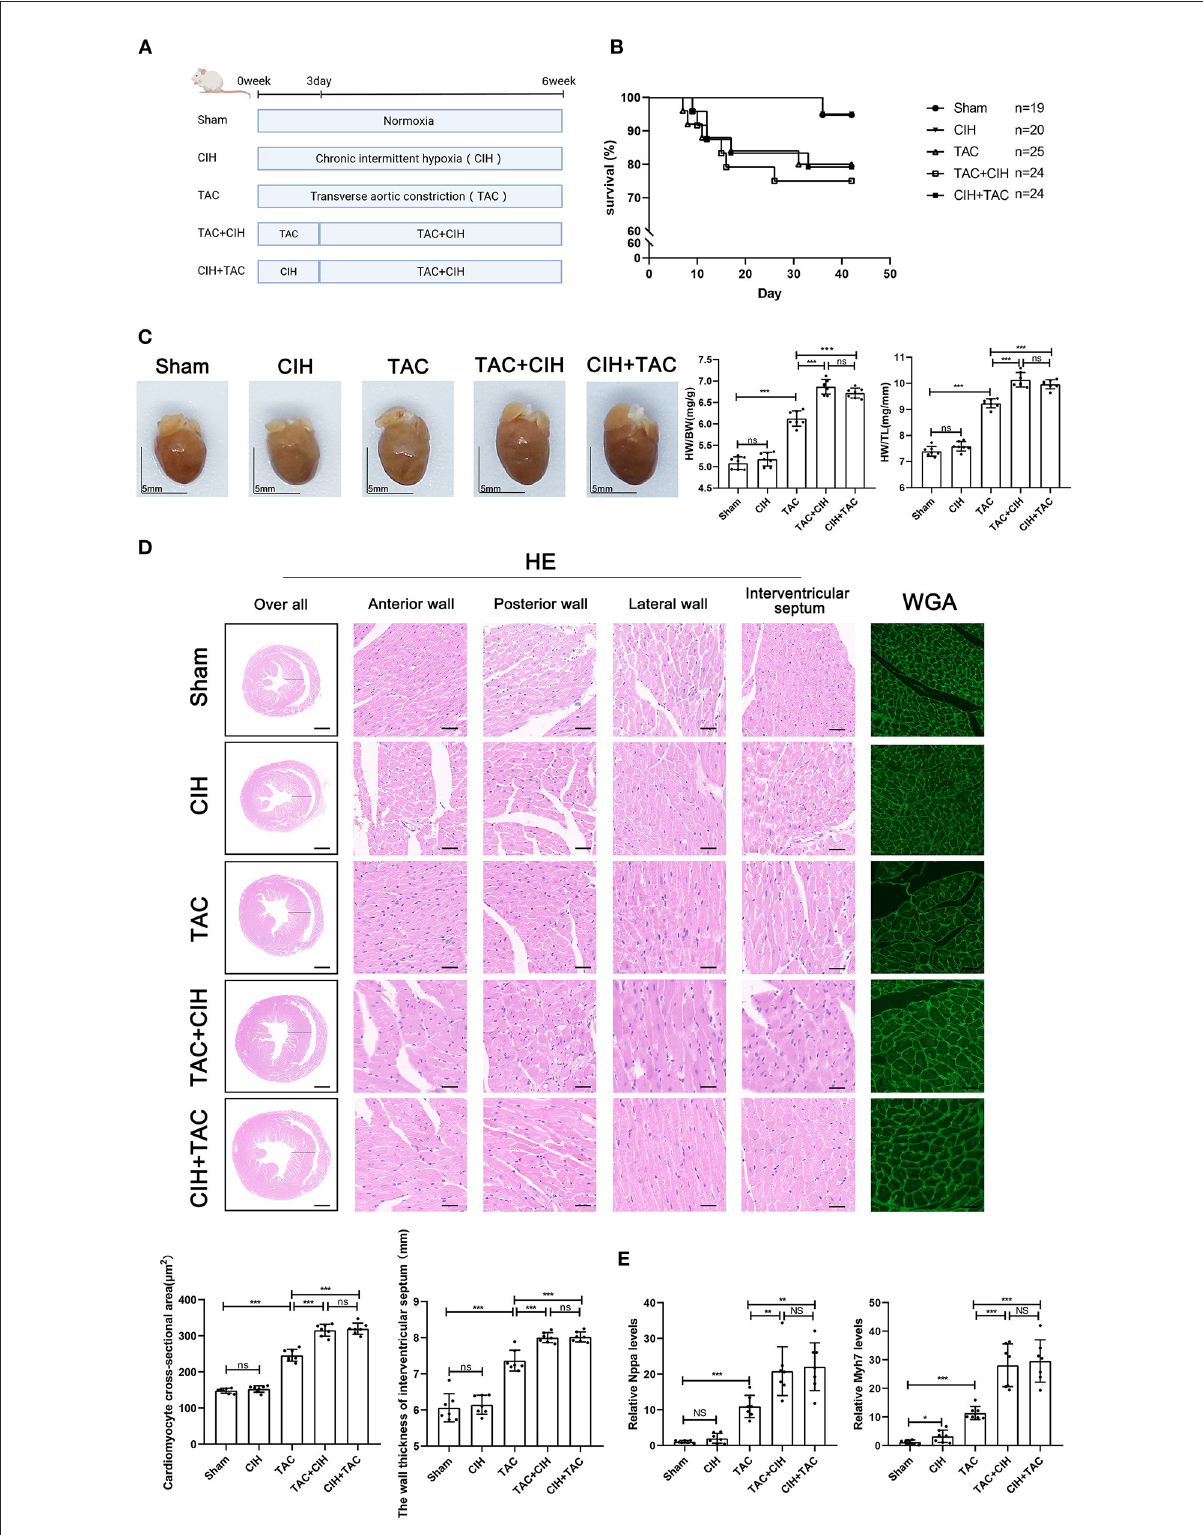
FIGURE1 CIH exposure does not affect basal mortality rates after TAC but promotes cardiomyocyte hypertrophy. (A) Grouping and experimental protocols for each group. Sham: thoracotomy only without transverse aortic constriction surgery, followed by 6 weeks in normoxia; CIH: thoracotomy only without transverse aortic constriction surgery, followed by 6 weeks in CIH exposure; TAC: transverse aortic constriction